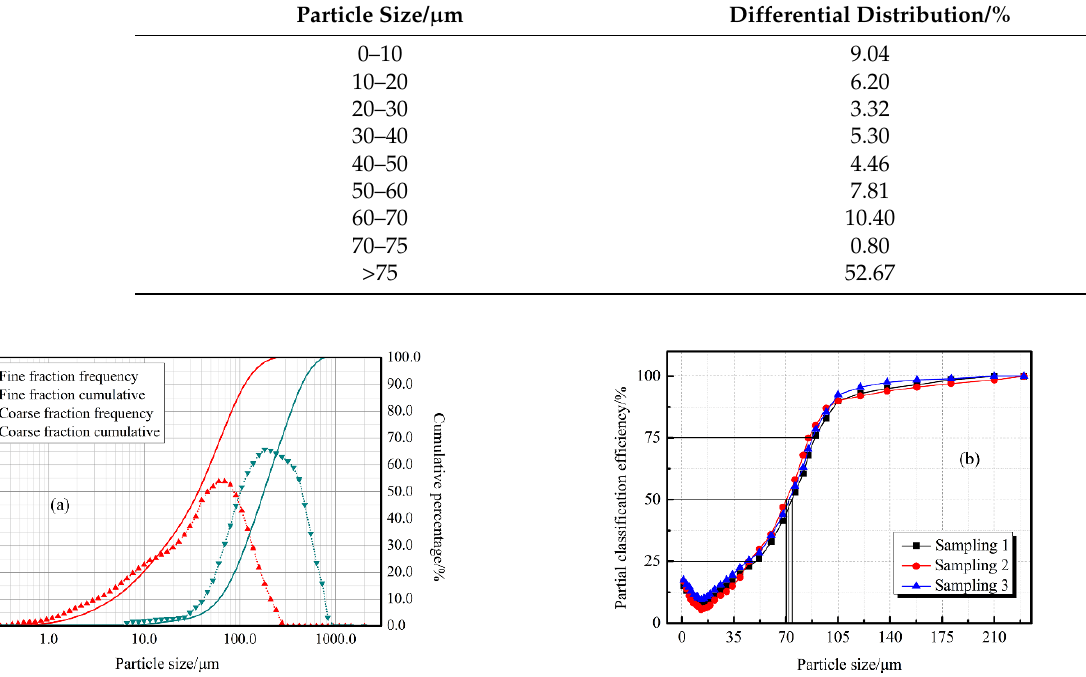
Table 8. Raw material particle size distribution.